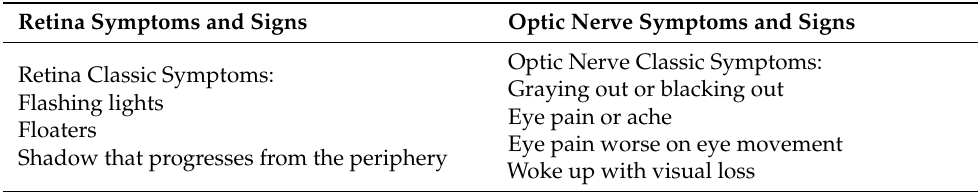
Table 4. Retina versus optic nerve etiologies of classic symptoms [31–33].